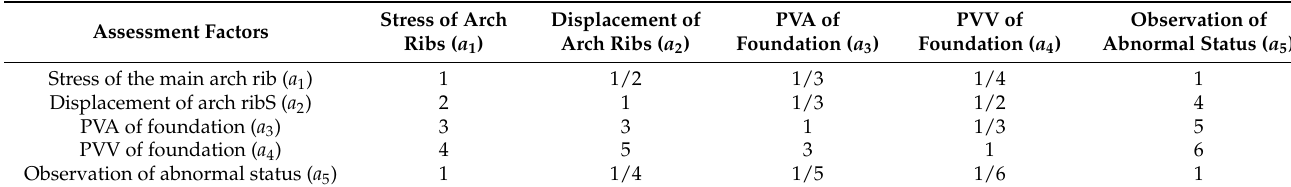
Table 3. Weight index of comprehensive evaluation during the nearby construction.